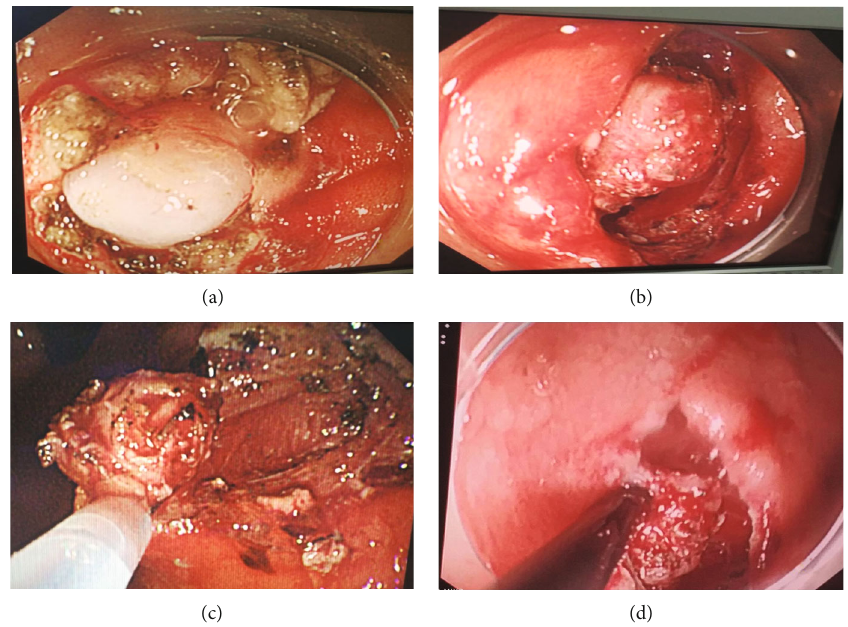
Figure 2: Real-time image procedure of endoscopic submucosal dissection (ESD) for small GISTs. (a, b) Endoscopic exposure of gastric stromal tumor. (c) Endoscopic removal of gastric stromal tumor. (d) Perforation during